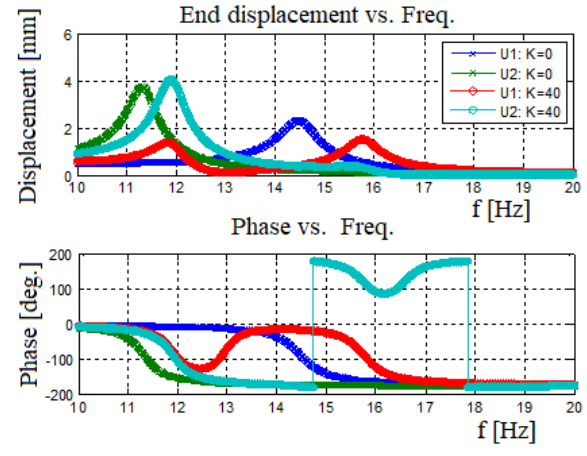
Figure 17. Amplitude and phase of the end mass: no spring case vs. connected spring case.